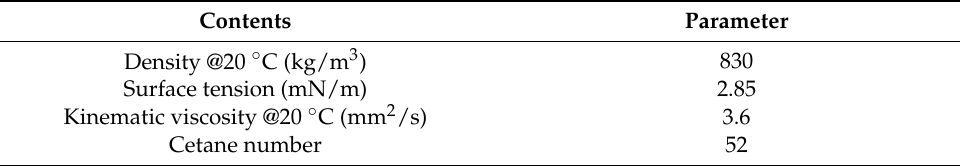
Figure 4. Schematic diagram of the single-cylinder test system. Table 4. Test system components. Table 5. Properties of 0#